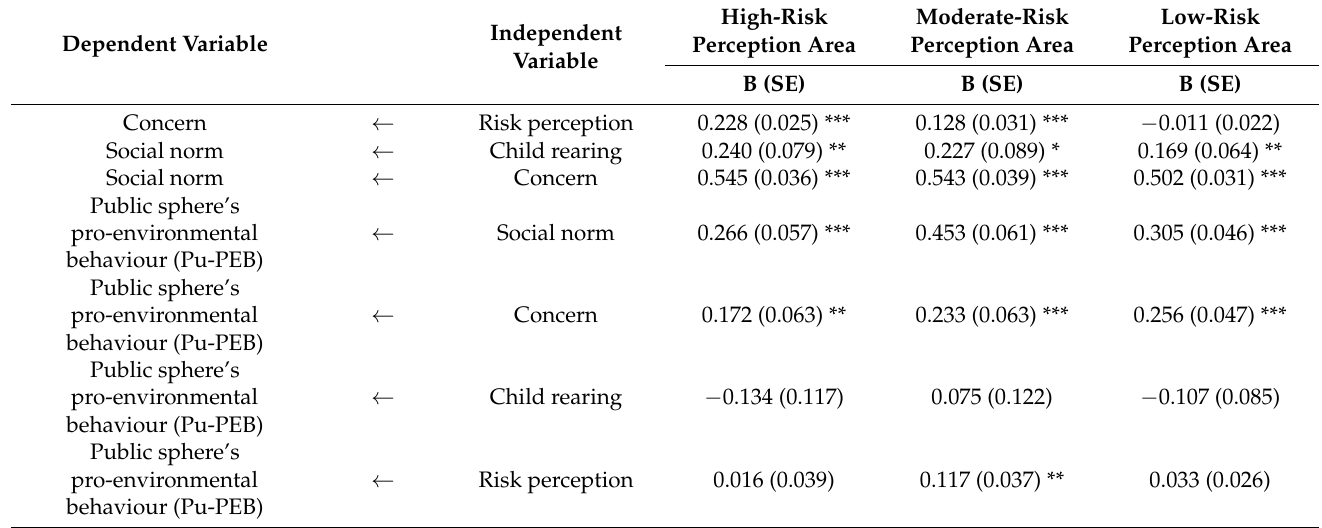
Table 4. The non-standardised regression coefficient and significance of each risk perception area in the simultaneous analysis of several groups.